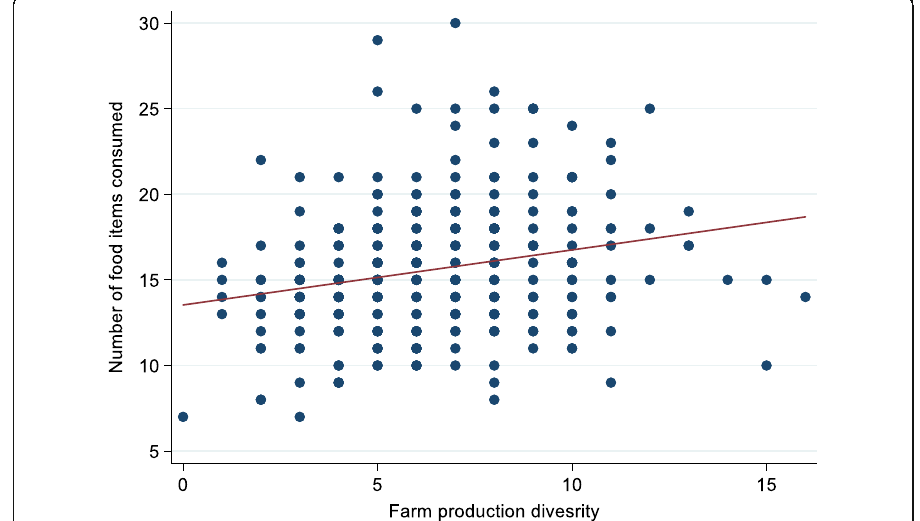
Fig. 6 Relationship between farm production diversity and household dietary diversity. Source: Authors ’ computation using study survey